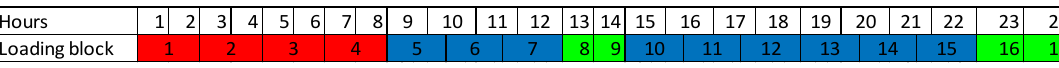
Figure 8. Exponential response curve for the first order system [40]. 5. Results and Discussion VNS-DEEPSO was selected based on the review of heuristic optimization algorithms [15,16,19]. This algorithm was proposed to solve 0-1 KP and DRF. In fact, the profits were optimized for the SMG model in Equation (1). This case study was optimized for 100 scenarios and 50,000 evaluations of objective function, as shown in Equation (10) [36]. Figure 9 summarizes the load curtailment with DR in percentage. The two methodologies are labeled as (Figure 9a) 0-1 KP and (Figure 9b) DRF. The blue area represents the percentage of load curtailment and the orange area represents the percentage of load shedding. The sum of the orange and blue area must be 100%, which represents the demand